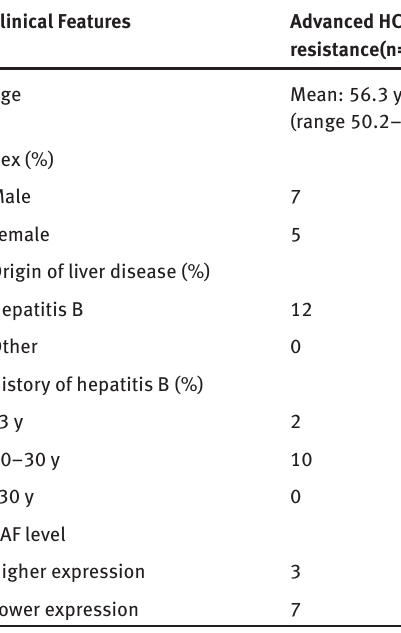
Table 1: Patient’s main characteristics. Clinical